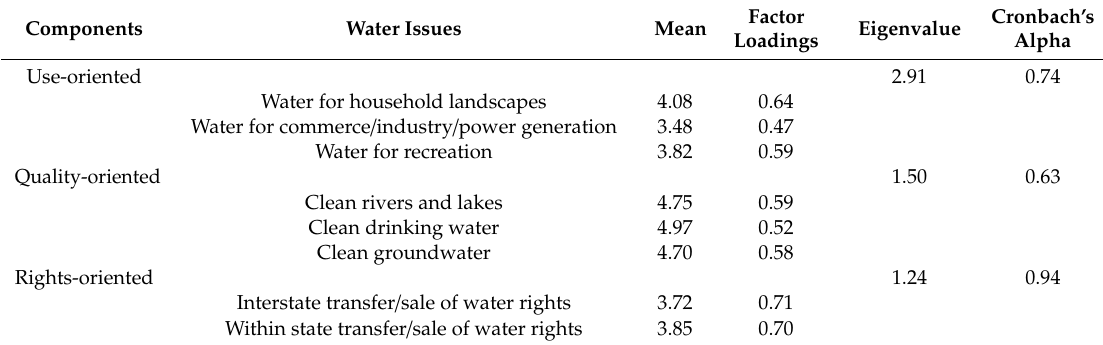
Table 1. Principal components derived from perceived importance of water issues in